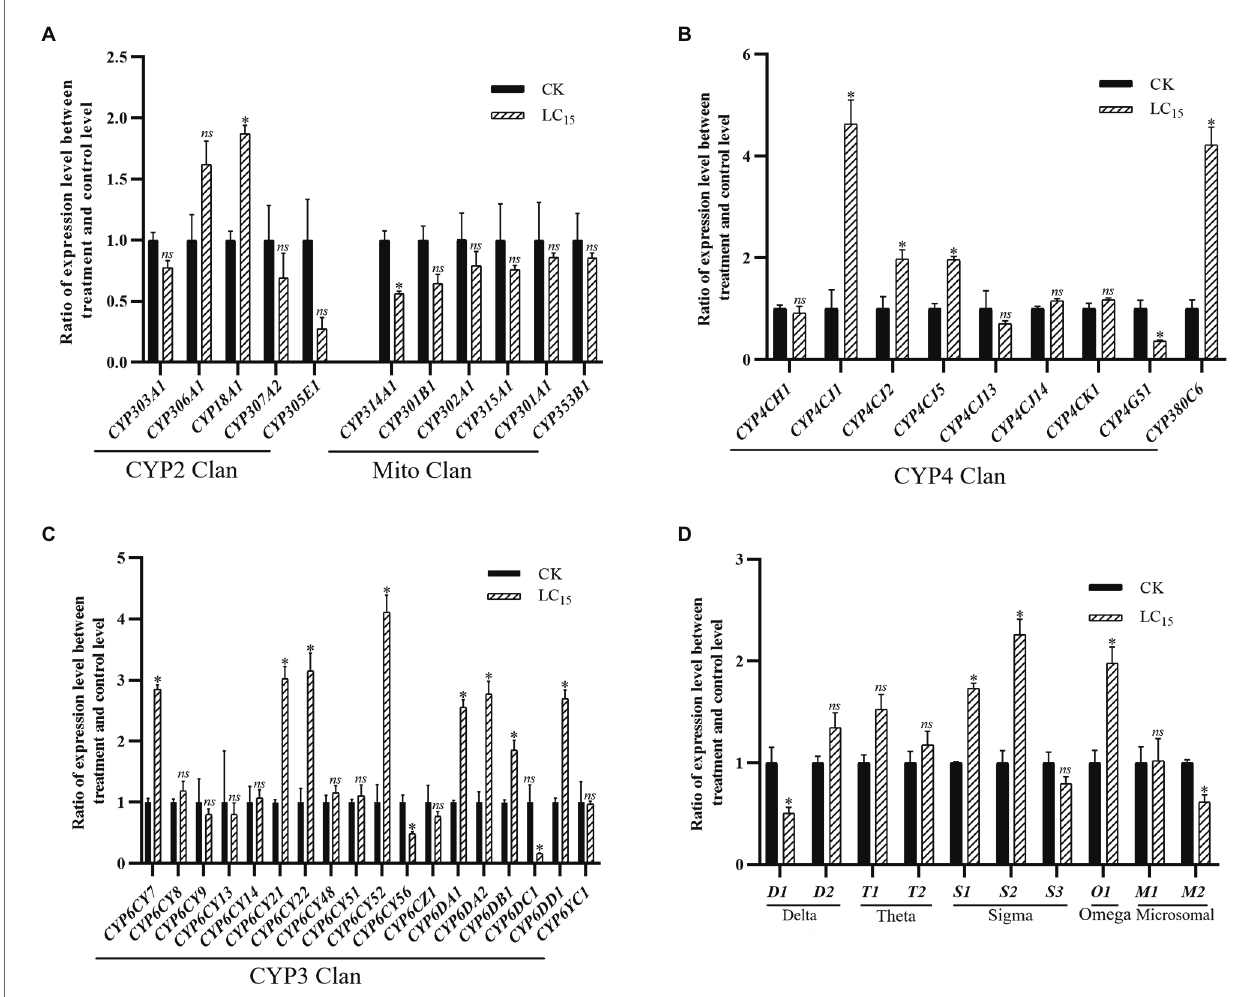
FIGURE 3 | Fold changes in the expression of 38 P450 genes and 10 GST genes in the A. craccivora susceptible strain after the LC 15 dose of imidacloprid treatment. The significant differences were marked by asterisks. *Significantly at 0.05 level. The ns represents no significant difference. (A) Fold changes in the expression of P450 genes from CYP2 and Mito Clan. (B) Fold changes in the expression of P450 genes from CYP4 Clan. (C) Fold changes in the expression of P450 genes from CYP3 Clan. (D) Fold changes in the expression of GST